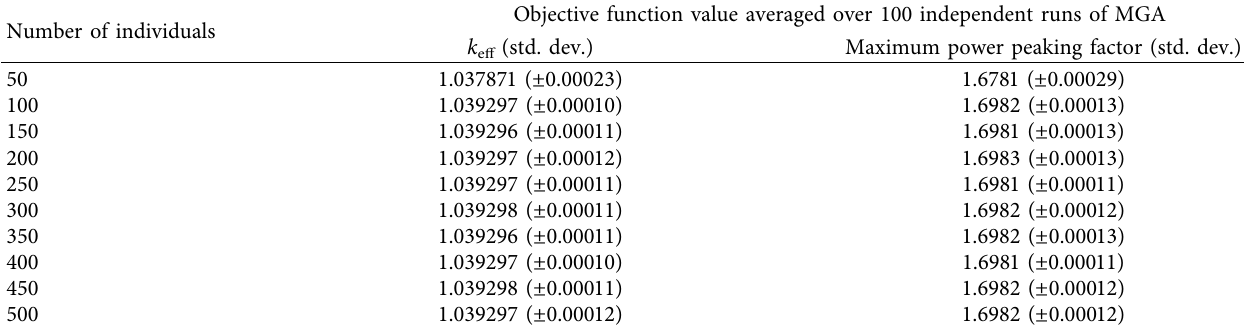
Table 3: Initial population sensitivity with varying number of individuals. Objective function value averaged over 100 independent runs of